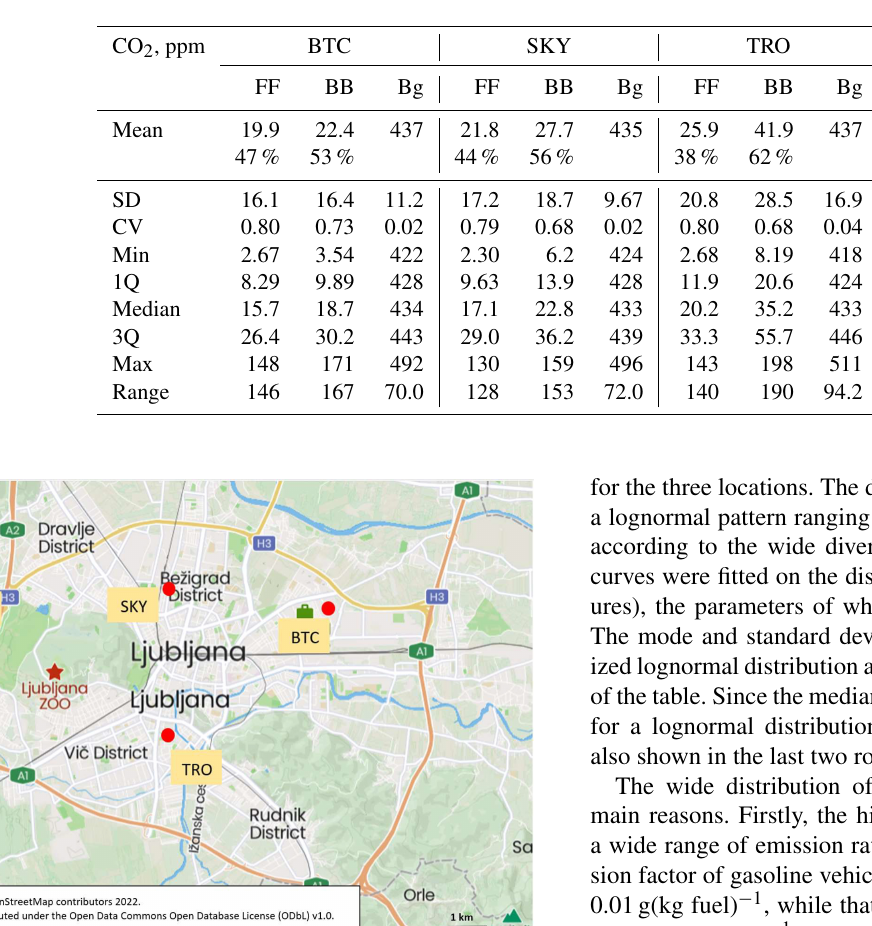
Table 7. Source apportionment of the combustion-related CO 2 and the background level (Bg) at the three monitoring locations as well as at the highway (FF component only). The mean (with the percental share with respect to the total combustion-related CO 2 ), standard deviation (SD), their ratio (coefficient of variation, “CV”), the three quartiles (1Q, “Median”, 3Q), minimum and maximum values, as well as their difference (“Range”) were calculated from hourly averages for the FF- and BB-related CO 2 concentration increments.